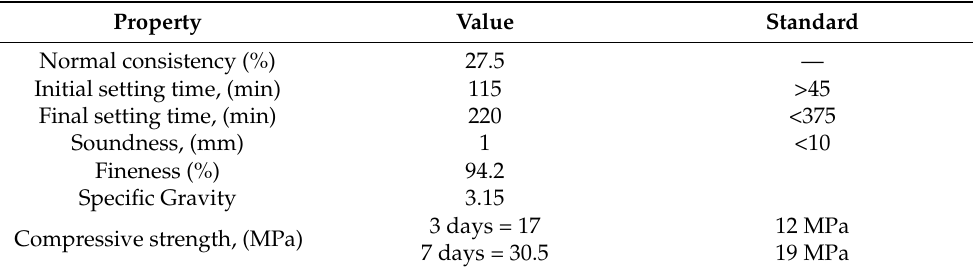
Table 1. Physical and mechanical properties of Portland cement.